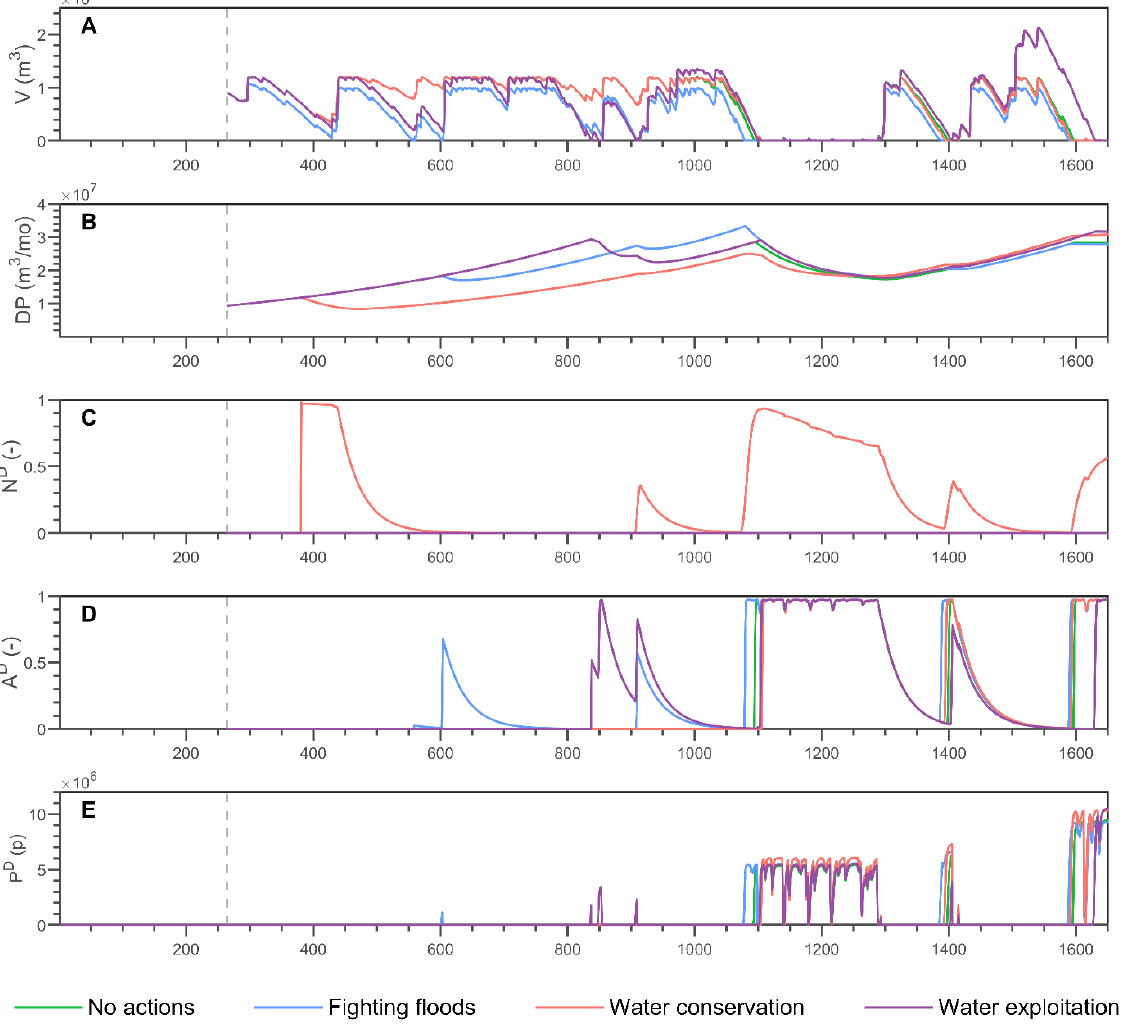
Figure A9. Water shortage-based variables of the synthetic experiments additional scenario #1 considering dam construction and human-flood interactions with the four water management strategies introduced in this study. (A) reservoir volume (V), (B) total water demand (DP), (C) willingness to the new per-capita demand (ND), (D) drought awareness (AD), and (E) population affected by droughts (PD). The grey dashed line indicates the construction of the Wivenhoe